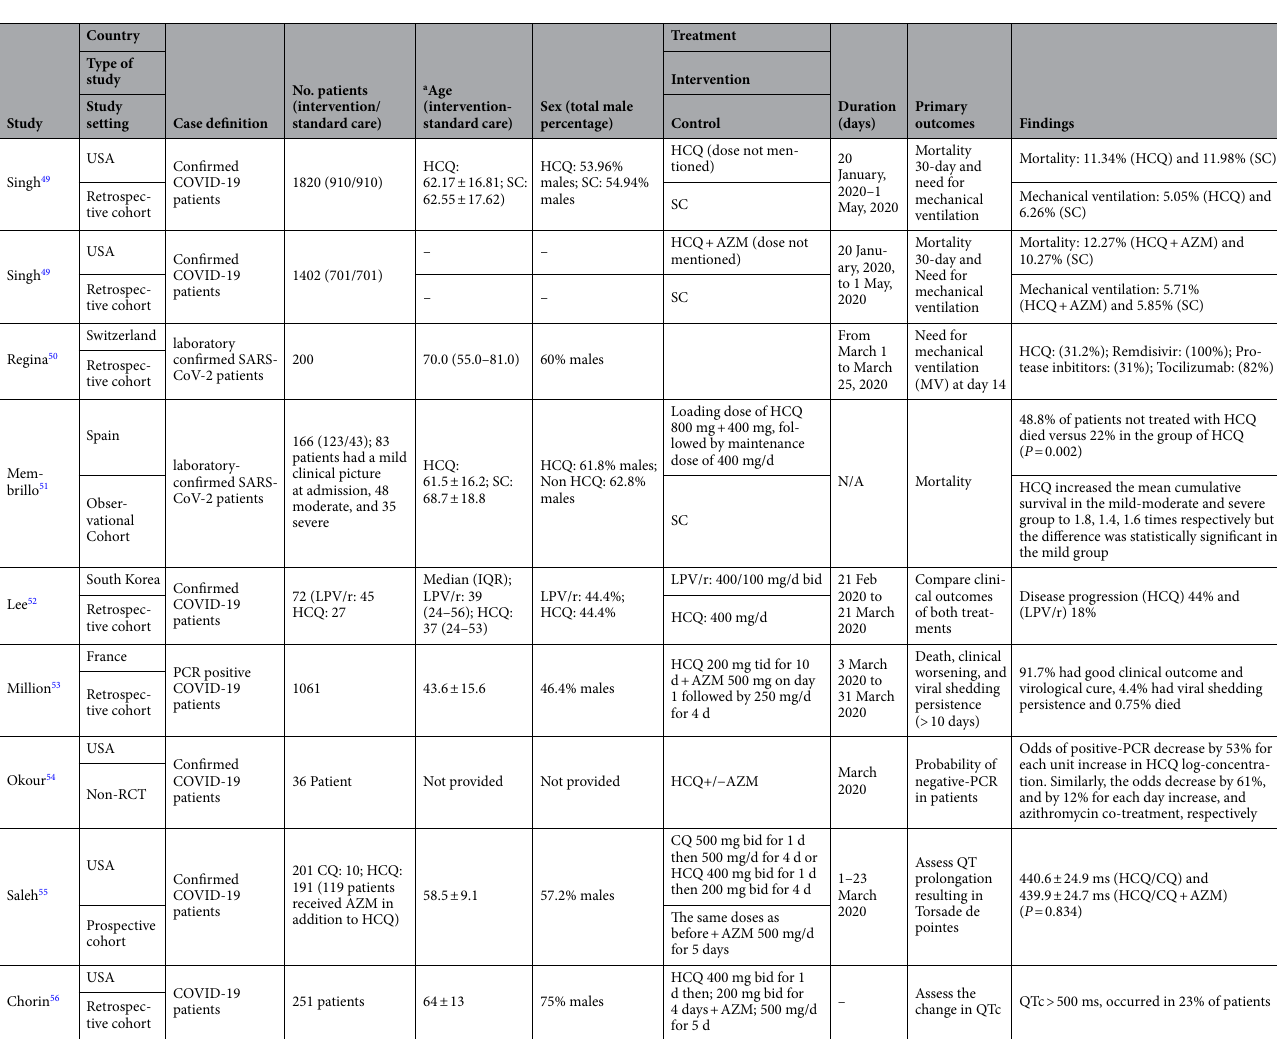
and by 12% for each day increase, and azithromycin co-treatment,